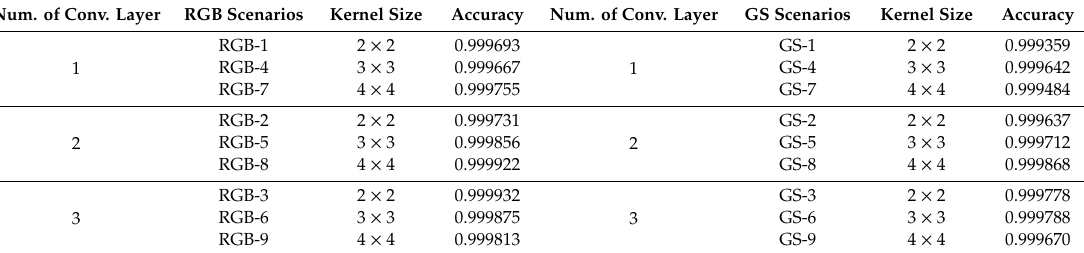
Figure 6. Electronics 2020 , 9 , x FOR PEER REVIEW